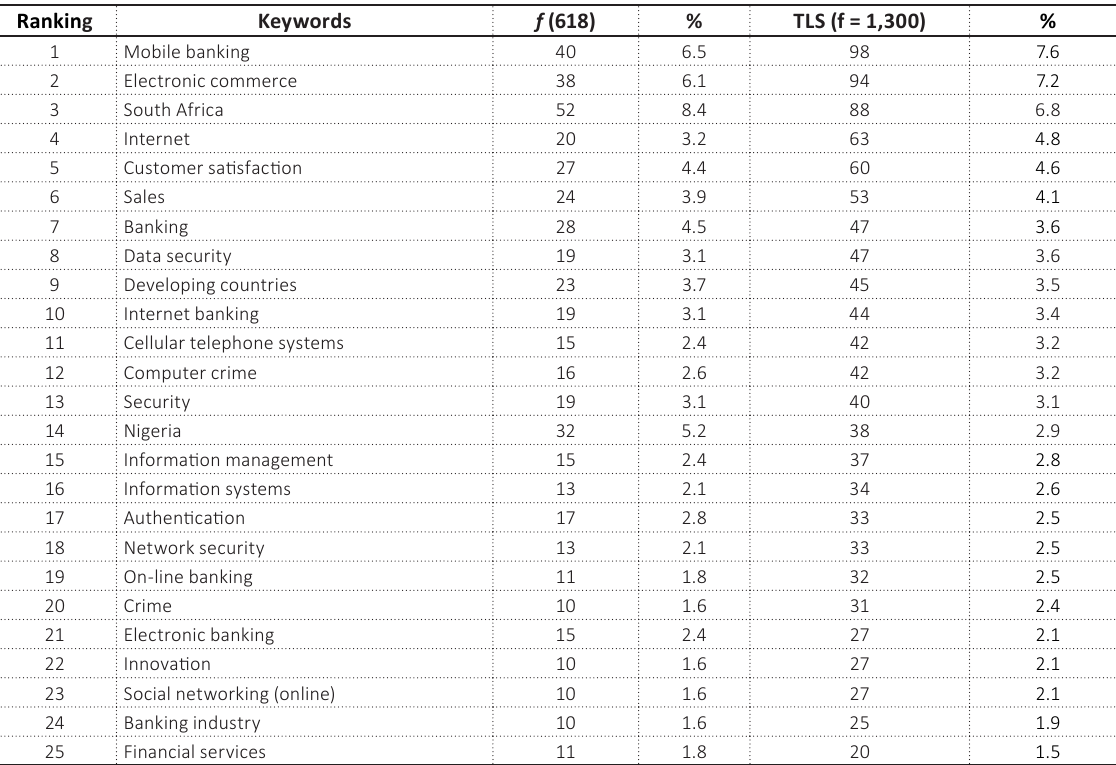
Table 3. Top 20 co-occurrences of key phrases and all major terms arranged based on the TLS (f = 1,300) of the Scopus database